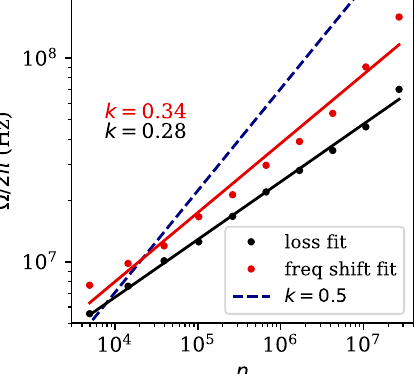
Fig. 3 Effective Rabi frequency of the pump extracted from fi ts as function of number of pump phonons. Data shown in black derives from fi ts to the probe loss in two-tone spectroscopy (Fig. 3b). The frequency shift (Fig. 3c) yields smaller values for the pump strength at high phonon numbers, shown here in red. Solid lines show fi ts to extract the scaling. The blue line shows the k = 0.5 slope predicted ffiffiffi p n by the STM, corresponding to Ω / A simpler model for the two-tone spectroscopy was derived in ref. 31 . Under the assumption of uniform coupling strength of TLSs to the resonant modes, the spectral hole has a Lorentzian lineshape. In Supplementary Note 1, we repeat the analysis of our two-tone spectroscopy data using this model and obtain a scaling for the Rabi frequency of Ω ∝ n 0.3 (Supplementary Figs. 1 – 3). That a similar scaling is obtained with different models suggests the disparate scaling between on- and off-resonant pumping is a real effect, although it does not explain its physical mechanism.